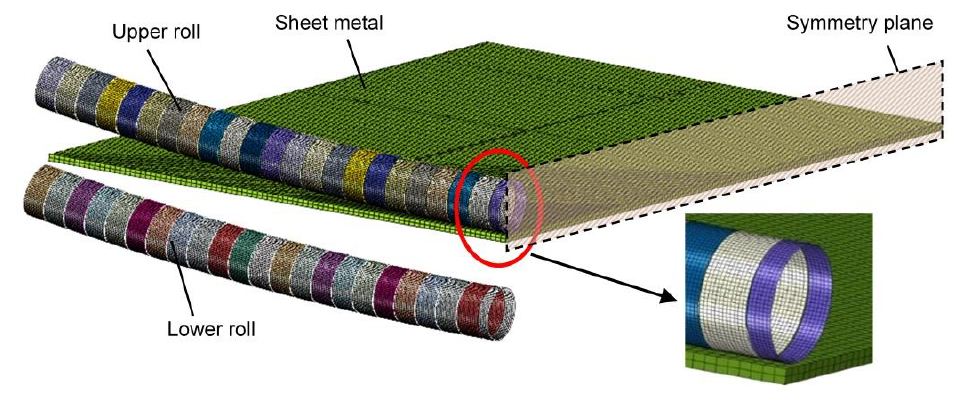
Figure 6. Finite element model. Table 1. Mechanical properties of 08 AL.